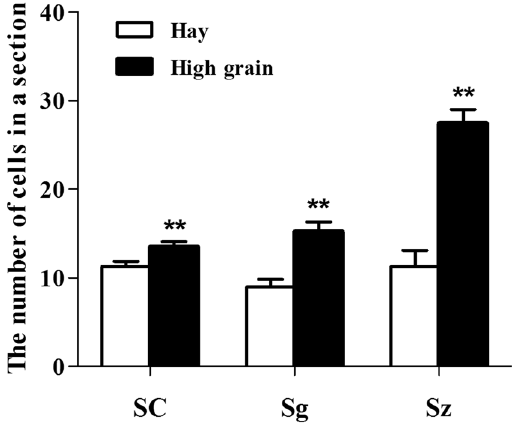
Figure 3. Analyses of the number of cells in seminiferous tubules. The number of Sertoli cells (SC), spermatogonia (Sg), and sperm (Sz) in the seminiferous tubules in the testes of sheep in the hay and high grain diet groups.